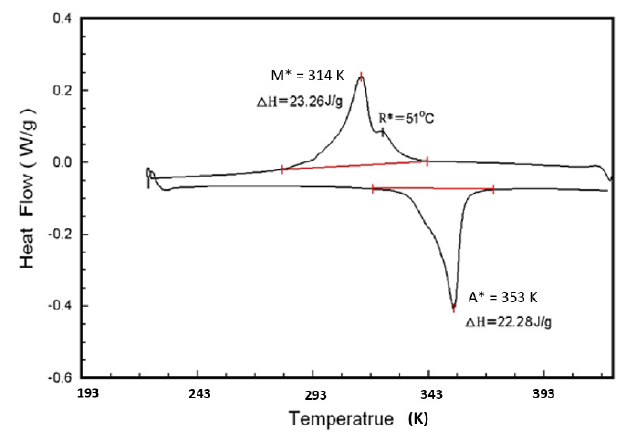
Figure 6. DSC curve of the Ti 50 Ni 49 W 1 alloy after 25 thermal cycles.